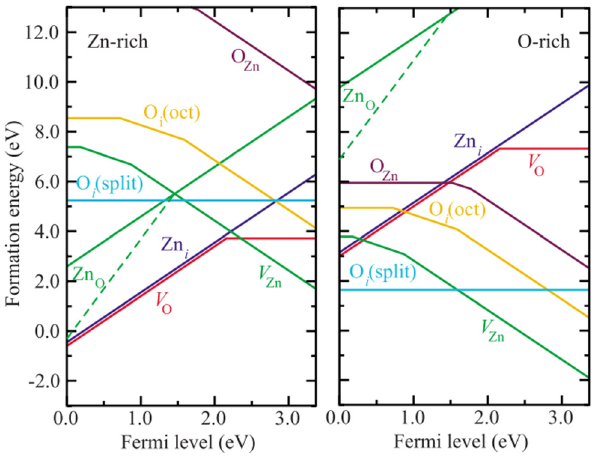
Figure 11: ( Color online ) Formation energies as a function of Fermi - level position for native point defects in ZnO. Results for Zn - rich and O - rich conditions are shown. The zero of Fermi level corresponds to the valence - band maximum. Only segments corresponding to the lowest - energy charge states are shown. The slope of these segments indicates the charge state. Kinks in the curves indicate transitions between dif - ferent charge states. Reproduced with permission from Elsevier [ 263 ]